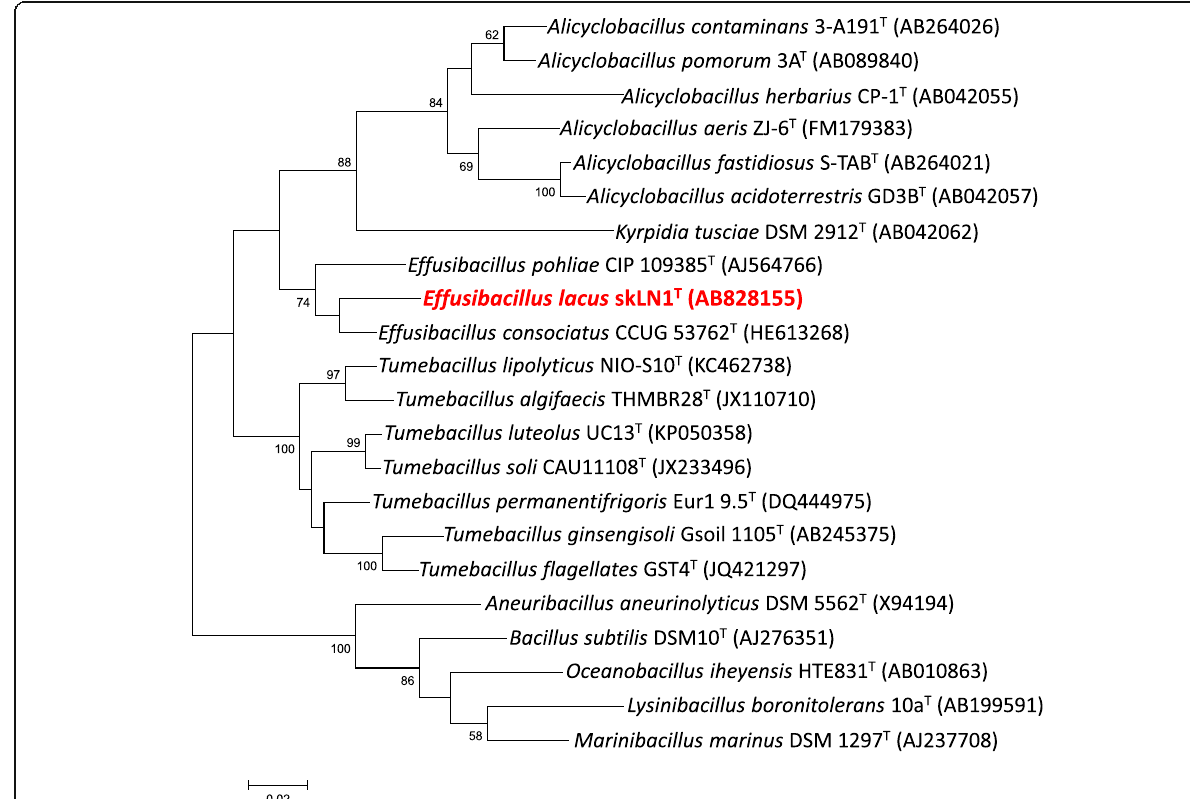
Fig. 2 Phylogenetic tree showing the relationship of Effusibacillus lacus strain skLN1 T and related representatives. The maximum-likelihood tree was constructed with MEGA version 7.0.20 [24] based on ClustalX version 2.1 [25] aligned sequences of 16S rRNA gene. Bootstrap values (percentages of 1000 replications) of ≥ 50% are shown at nodes